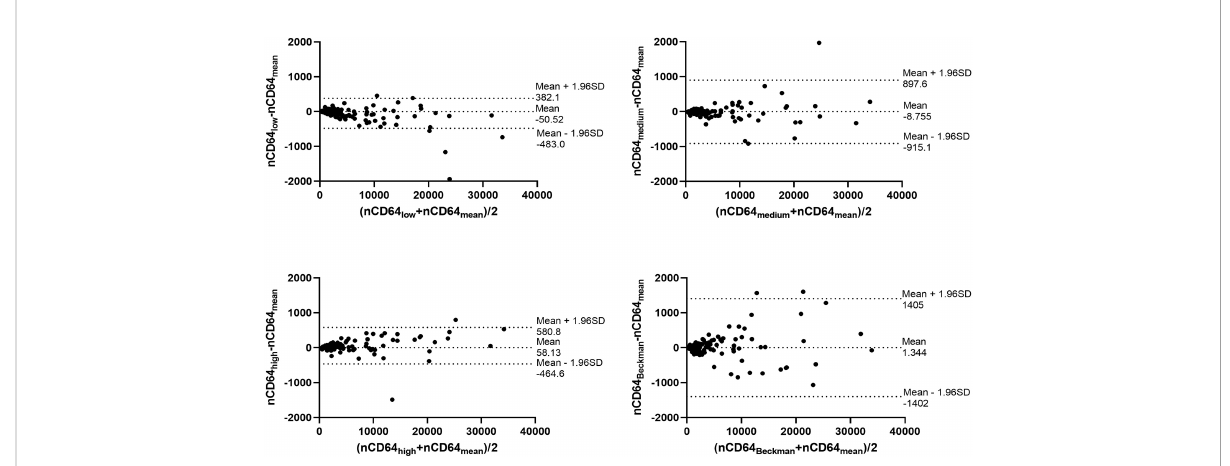
FIGURE 2 The Bland-Altman plot for the four MESFs of nCD64 under BD FACSCanto II with high/medium/high voltages and Beckman Coulter DxFlex with proper voltage. The agreement between the mean value of the four results and each result of nCD64 was assessed over the full range. The fi xed range was de fi ned as mean ± 1.96SD. nCD64, neutrophil CD64; SD, standard deviation; MESF, molecules of equivalent soluble fl